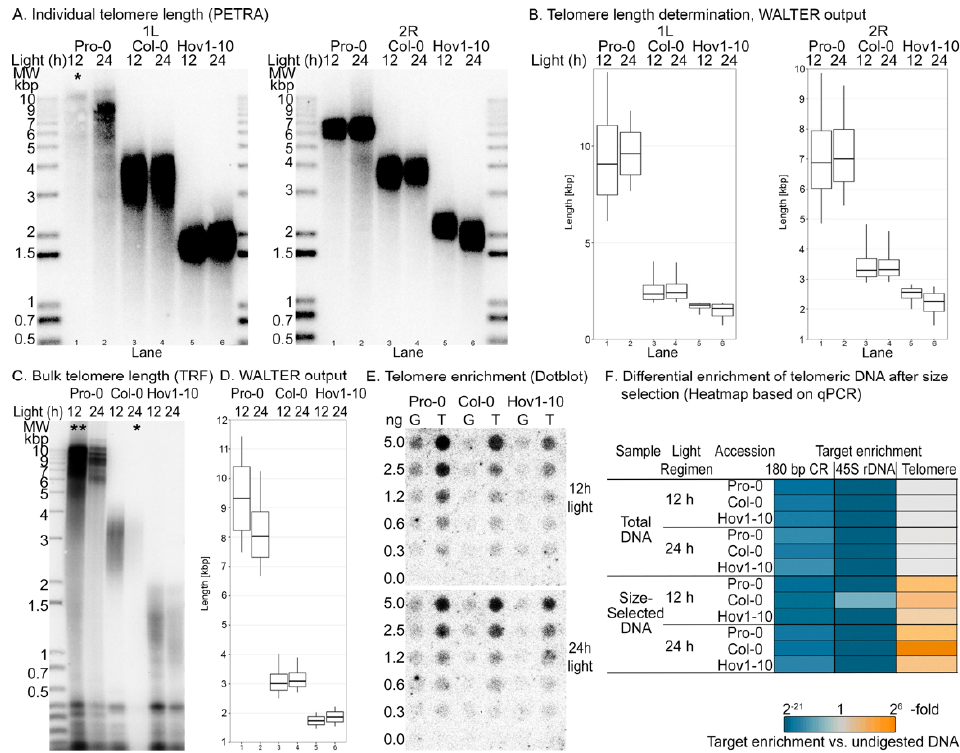
Figure 2. Telomeric DNA is specifically enriched by digestion and size-selection. ( A ) Assessment of telomere length of individual chromosome arms by PETRA. Top, chromosome 1, left arm (5 (cid:48) ). Bottom, chromosome 2, right arm (3 (cid:48) ). Telomeric DNA amplicons were detected by Southern blot with a 32 P-radiolabeled telomere probe. ( B ) Determination of telomere length from PETRA signal in panel ( A ) using the online tool, WALTER (49). ( C ) Assessment of bulk telomere length by TRF. Telomeric DNA was detected by Southern blot with a 32 P-radiolabeled telomere probe. ( D ) Determination of mean telomere length from TRF in panel ( C ) using the online tool, WALTER (49). ( E ) Dot blot of a two-fold dilution series of the initial and final samples, hybridized with a 32 P-radiolabeled telomeric DNA probe demonstrates the telomere enrichment after depletion of small DNA fragments in the Mse I-digested samples. G denotes for total Mse I digested DNA (initial sample), and T denotes size-selected DNA (final sample). ( F ) qPCRs for centromeric (180 bp), ribosomal (45S rDNA), and telomeric repeats in total digested DNA and in size-selected samples. Enrichment was calculated with the 2 − ∆ Cq method, using total undigested DNA as control (Cq is cycle of quantification, also known as Ct or threshold cycle). Single asterisk (*) denotes lanes with low intensity signal, double asterisk (**) denotes an overloaded sample. We provide higher and lower intensity visuals in Figure S1 to improve the readability of results in the marked